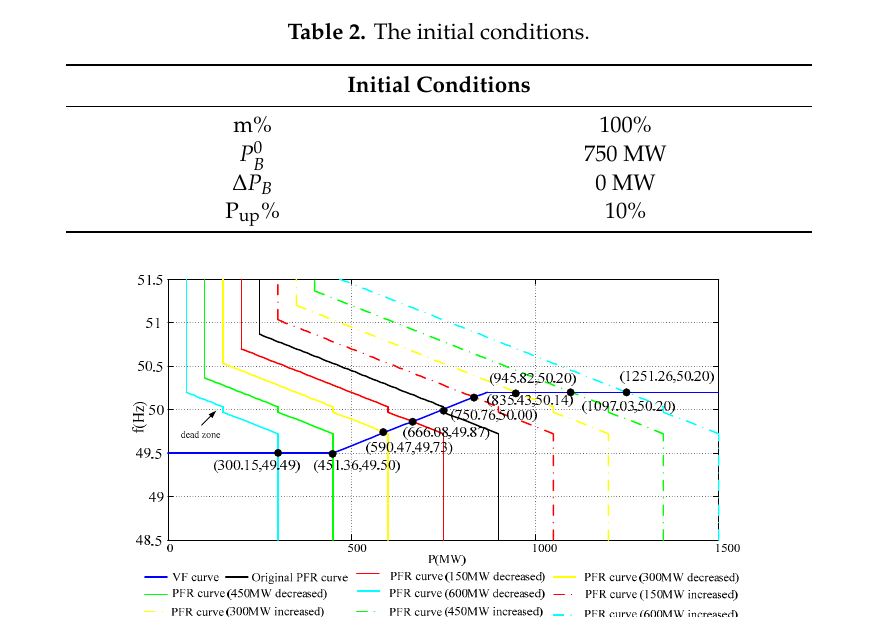
Figure 7. VF curve and PFR curves (control parameters Group 1).